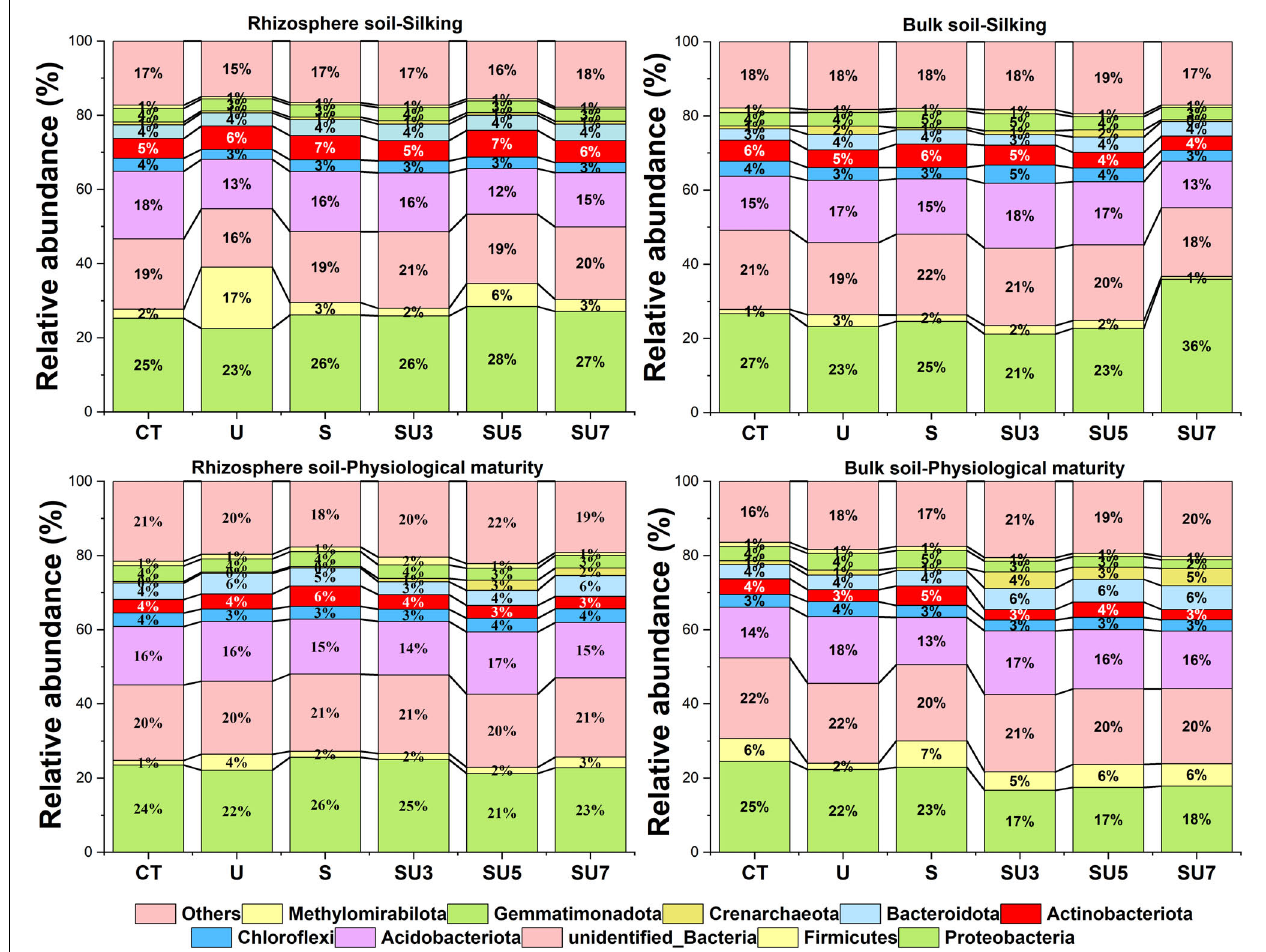
FIGURE 3 | Effect of nitrogen fertilizer treatments (including CT, U, S, SU3, SU5, and SU7) on the microbial community composition of rhizosphere and bulk soil at different maize growth stages (i.e., silking and physiological maturity).